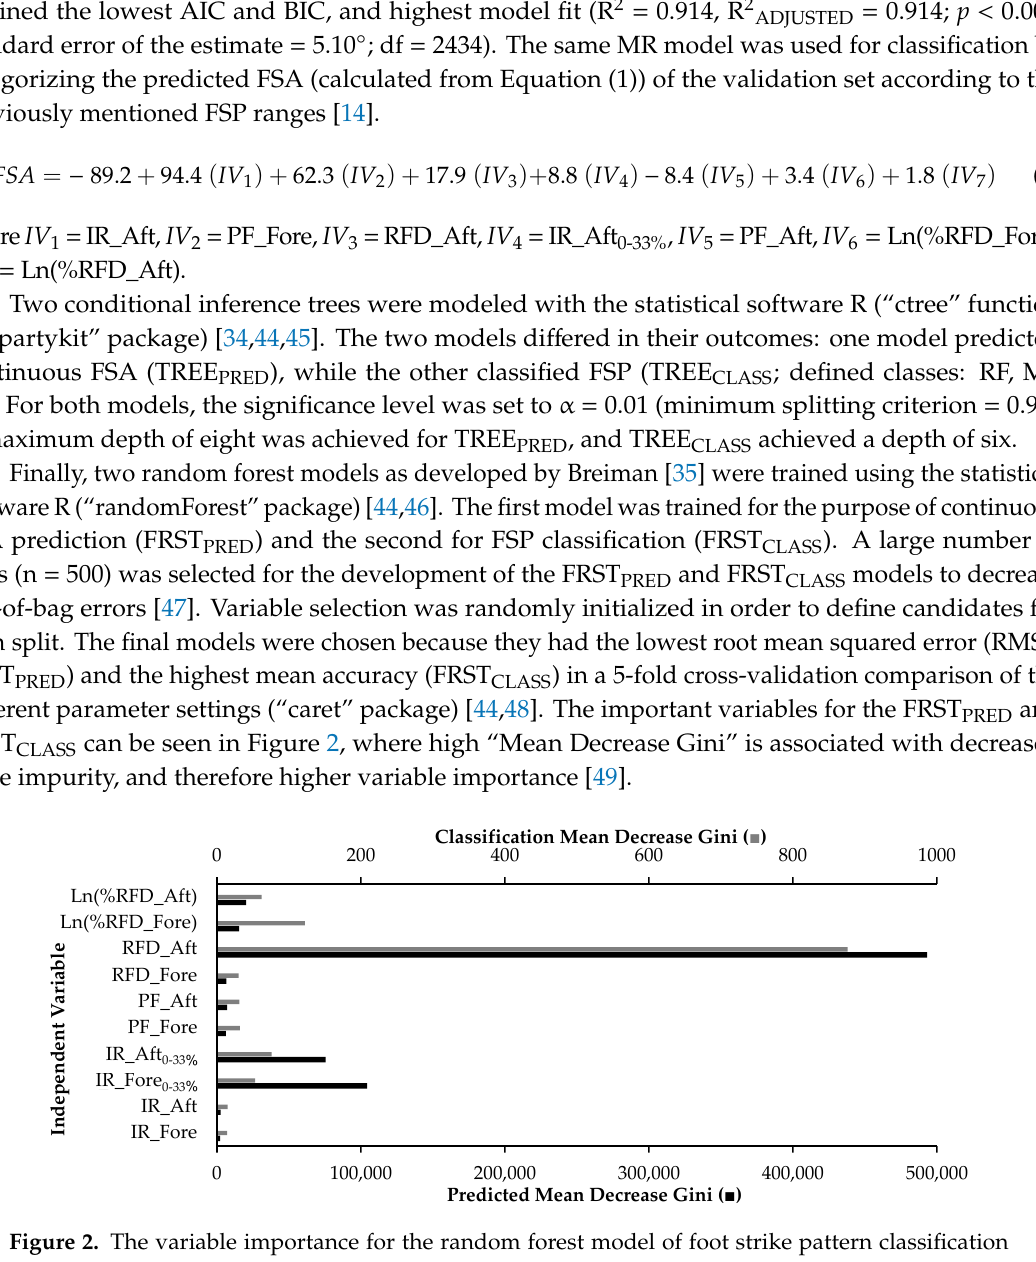
Figure 2. The variable importance for the random forest model of foot strike pattern classification is presented with gray bars (scaled to the secondary x -axis), while the foot strike angle prediction is presented in black (primary x -axis). The variables of higher importance can be seen with larger “Mean Decrease Gini.”.